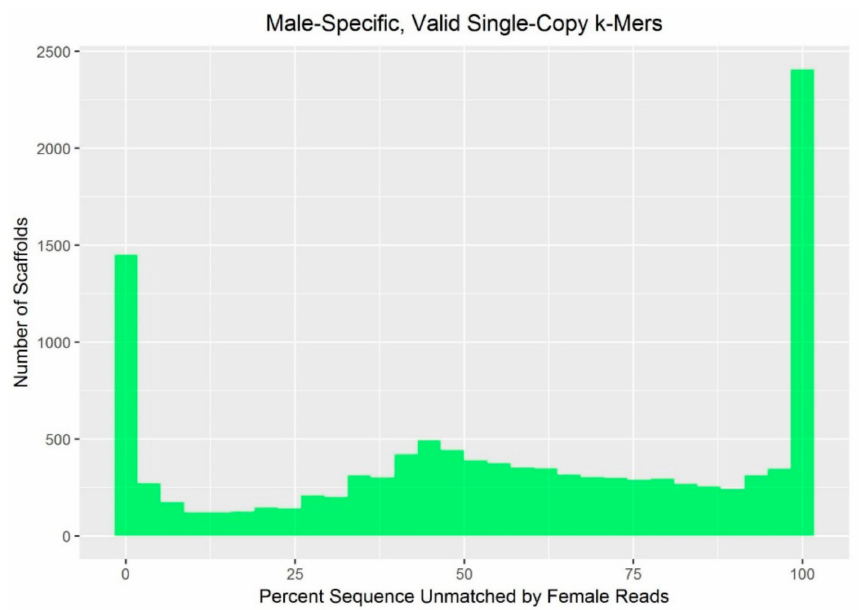
Figure 2. The distribution of male-specific sequence among sca ff olds. This histogram indicates the percent of valid, single-copy k -mers unmatched in the female reads across all sca ff olds